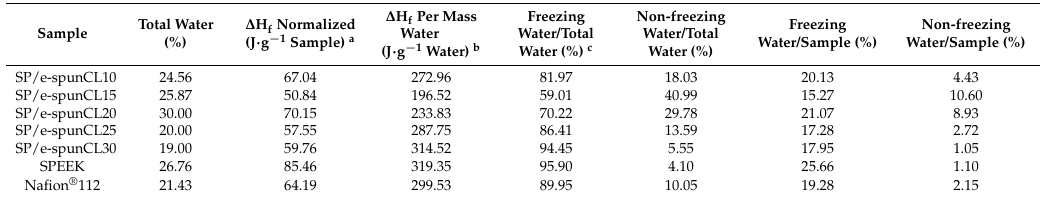
Table 6. Composition of water type in SP/e-spunCL10, SP/e-spunCL15, SP/e-spunCL20, SP/e-spunCL25,